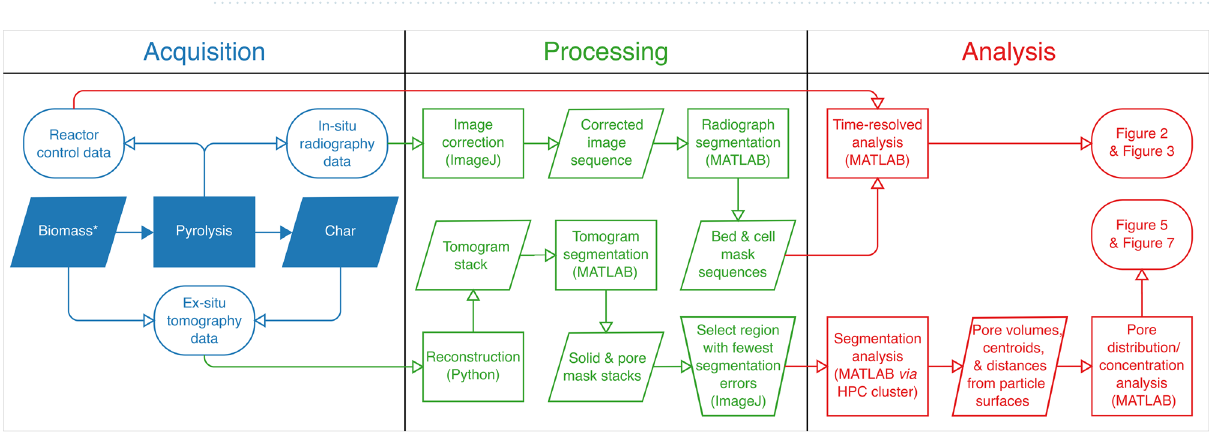
Figure 9. Pipeline diagram for data acquired during and after pyrolysis. Symbol meanings follow ISO 5807:1985: Information Processing 59 . Filled symbols represent physical systems; unfilled symbols represent